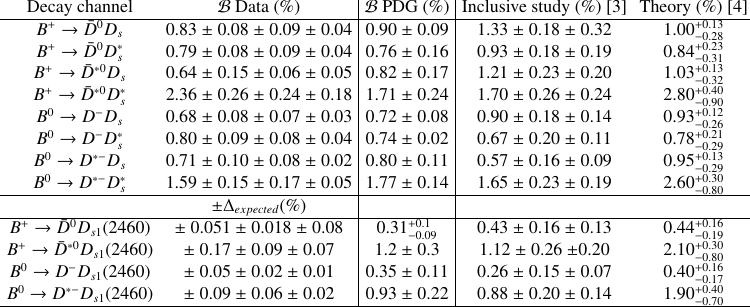
Decay channel B Data (%)